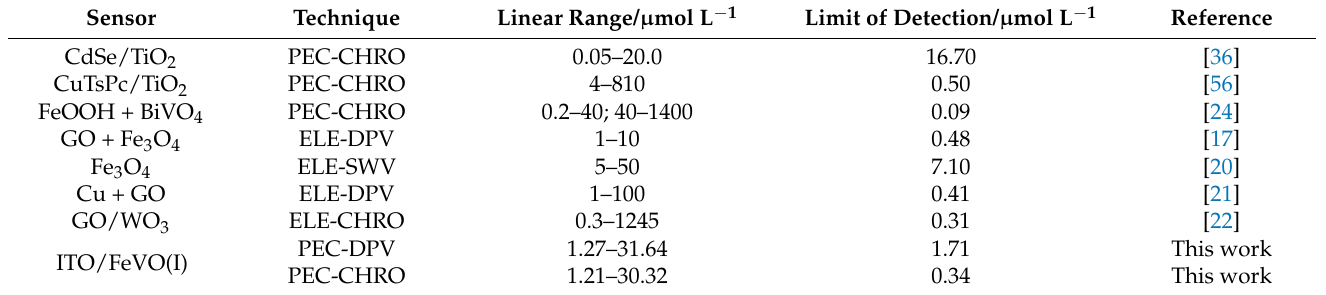
Table 4. Comparison of analytical conditions of ITO/FeVO(I) with other electrochemical and photo- electrochemical sensors for dopamine